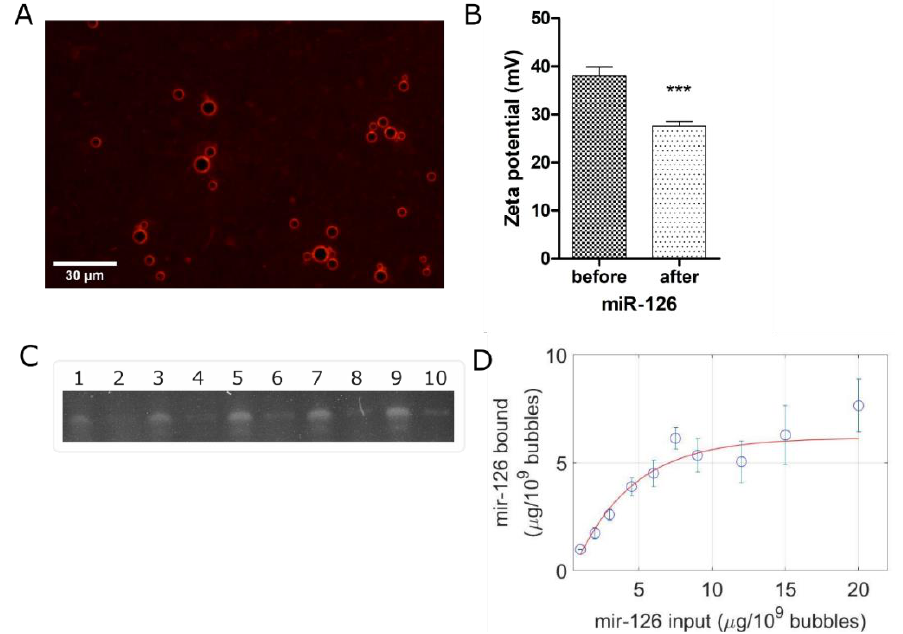
Figure 3. Gene coupling characterization results in 6 µg of miR-126 per 10 9 microbubbles. ( A ) Fluorescent siRNA localization on microbubble surface. Scale bar: 30 µm. ( B ) Surface charge before and after coupling of 6 µ g of miR-126 per 10 9 microbubbles. ( C ) Acrylamide/urea PAGE of miR-126 bind- ing capacity on DSTAP: odd-numbered lanes show free miR-126 in DEPC H 2 O and even-numbered lanes show unbound miR-126 after incubation with DSTAP. ( D ) Quantification of miR-126 binding capacity on DSTAP. (***: p <